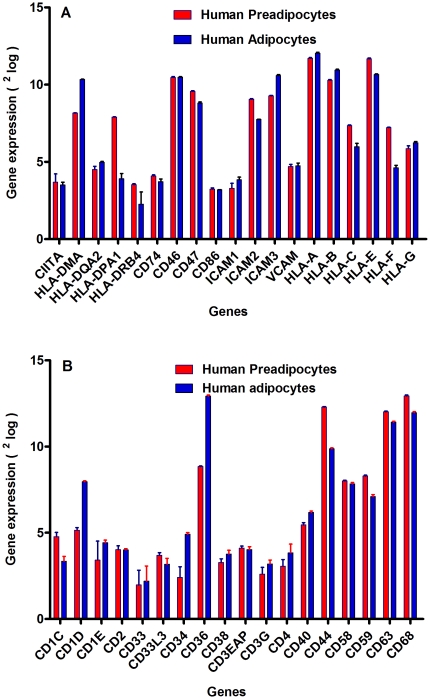
The expression of the MHC class II genes, receptors involved in (co)stimulation of T cells and immune-associated cluster differentiation (CD) by human primary pre-adipocytes and adipocytes.
Panel A shows the expression of MHC class II genes and some genes involved in co-stimulation of T cells in human pre-adipocytes (red bars) and adipocytes (blue bars). Gene expression was given as 2log and shown on the y-axis. Illumina results were obtained from two independent experiments. Each experiment was done in duplicate, thus, each sample was measured four times. Panel B shows CD gene expression by human adipocytes, using Illumina BeadArray. Illumina gene profiling analysis shows the expression of CD genes in human pre-adipocytes (red bars) and adipocytes (blue bars). Gene expression was expressed as 2log and shown on the y-axis.